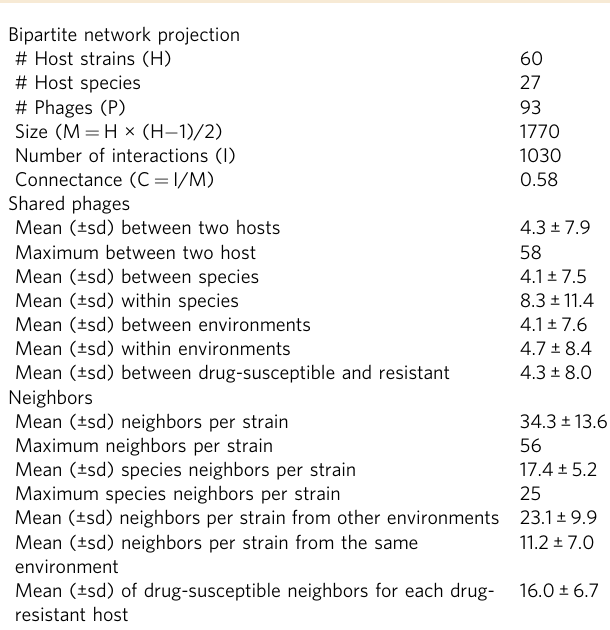
Table 2 General properties of the bipartite network projection. In the bipartite network projection, hosts are nodes and the number of shared phages are weighted edges between